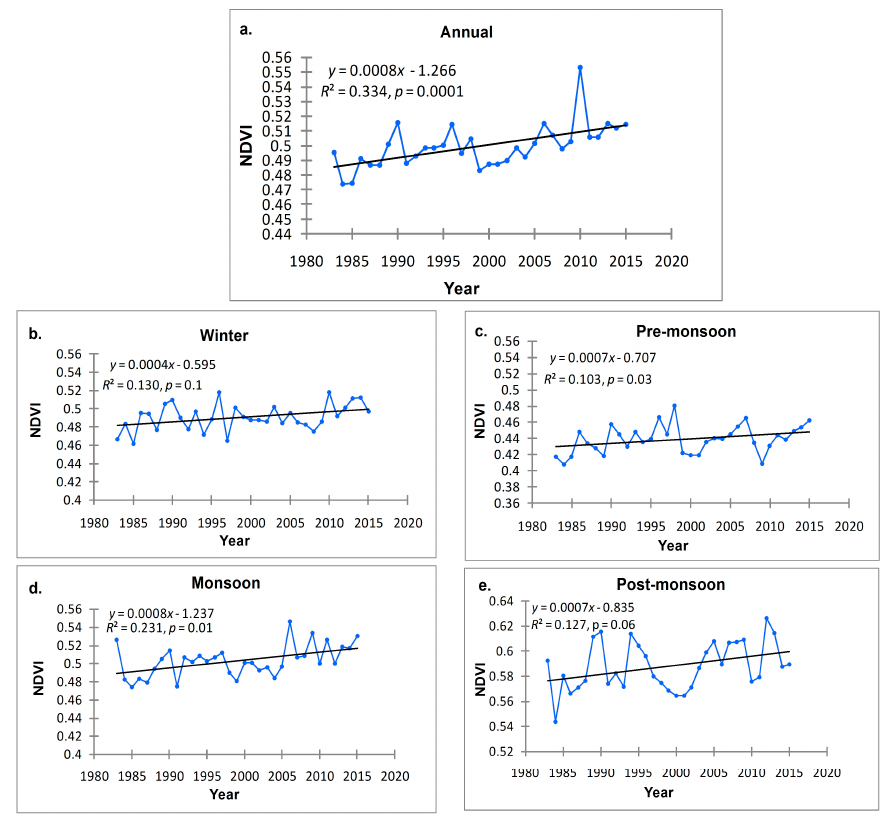
Figure 2. Temporal variation of GIMMS NDVI trend: ( a ) Annual; ( b ) Winter; ( c ) Pre-monsoon; ( d )